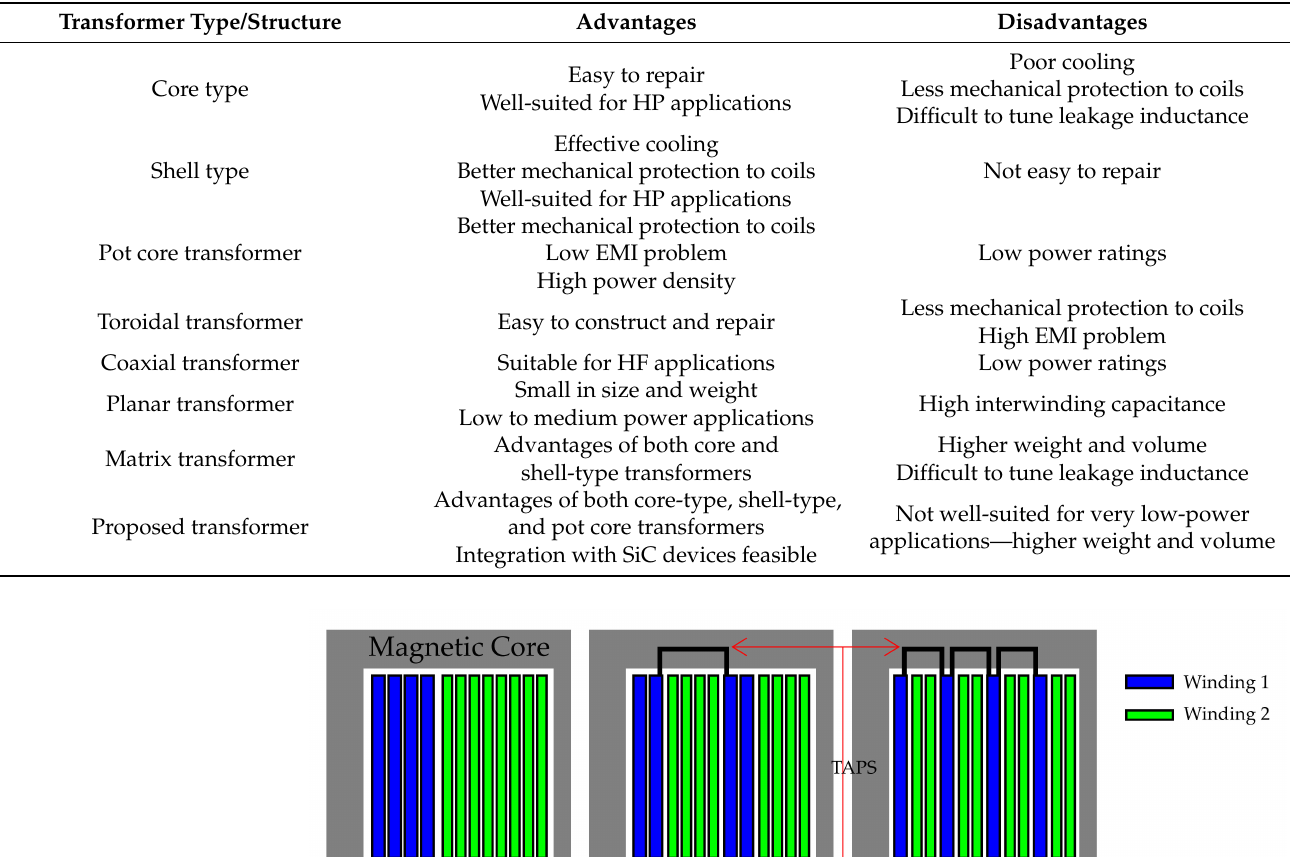
Table 2. Comparison of the proposed HF transformer with other HF transformers.